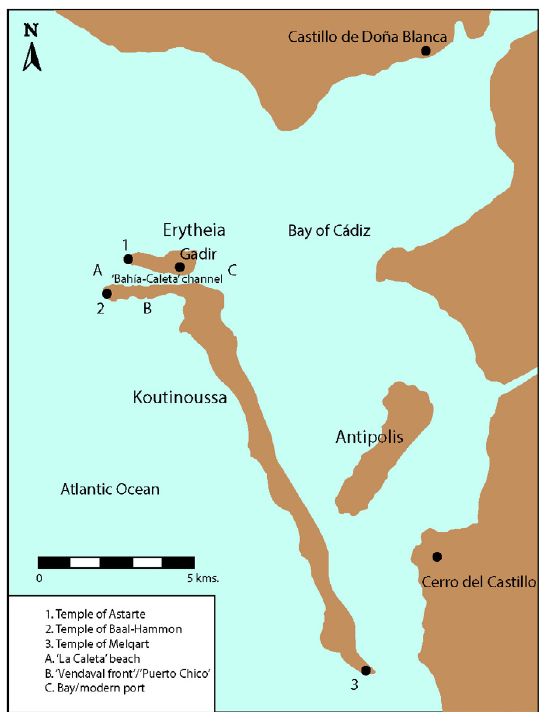
Figure 2. The Bay of Cadiz in Phoenician-Punic times (Niveau-de-Villedary, 2018, p. 106, Fig.